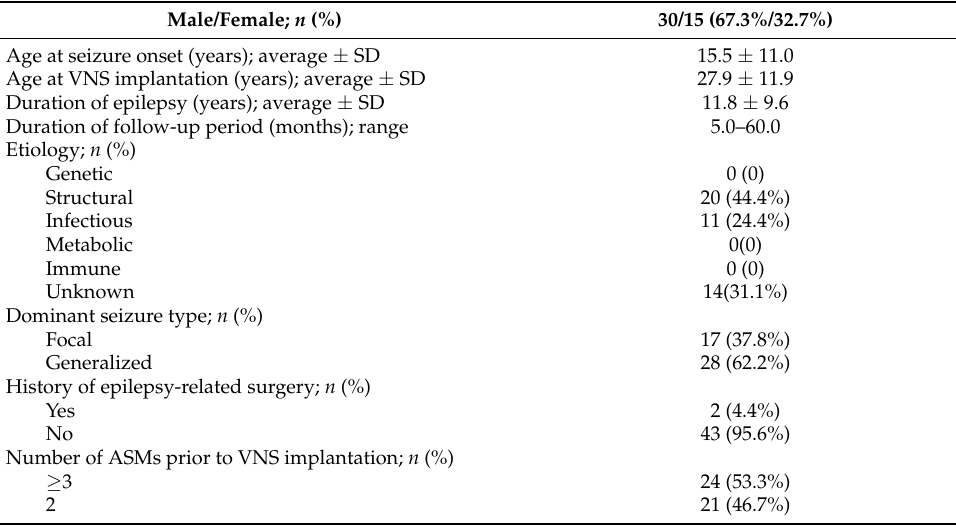
Table 1. Demographic and clinical features of VNS patients ( n =